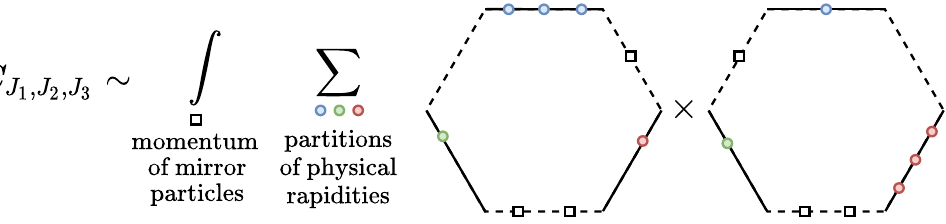
Figure 8 . Each closed spin chain operator is split into two open chain operators. We sum over all the ways its excitations can end up in either one of the chains. Gluing the hexagons together amounts to integrating over all possible mirror